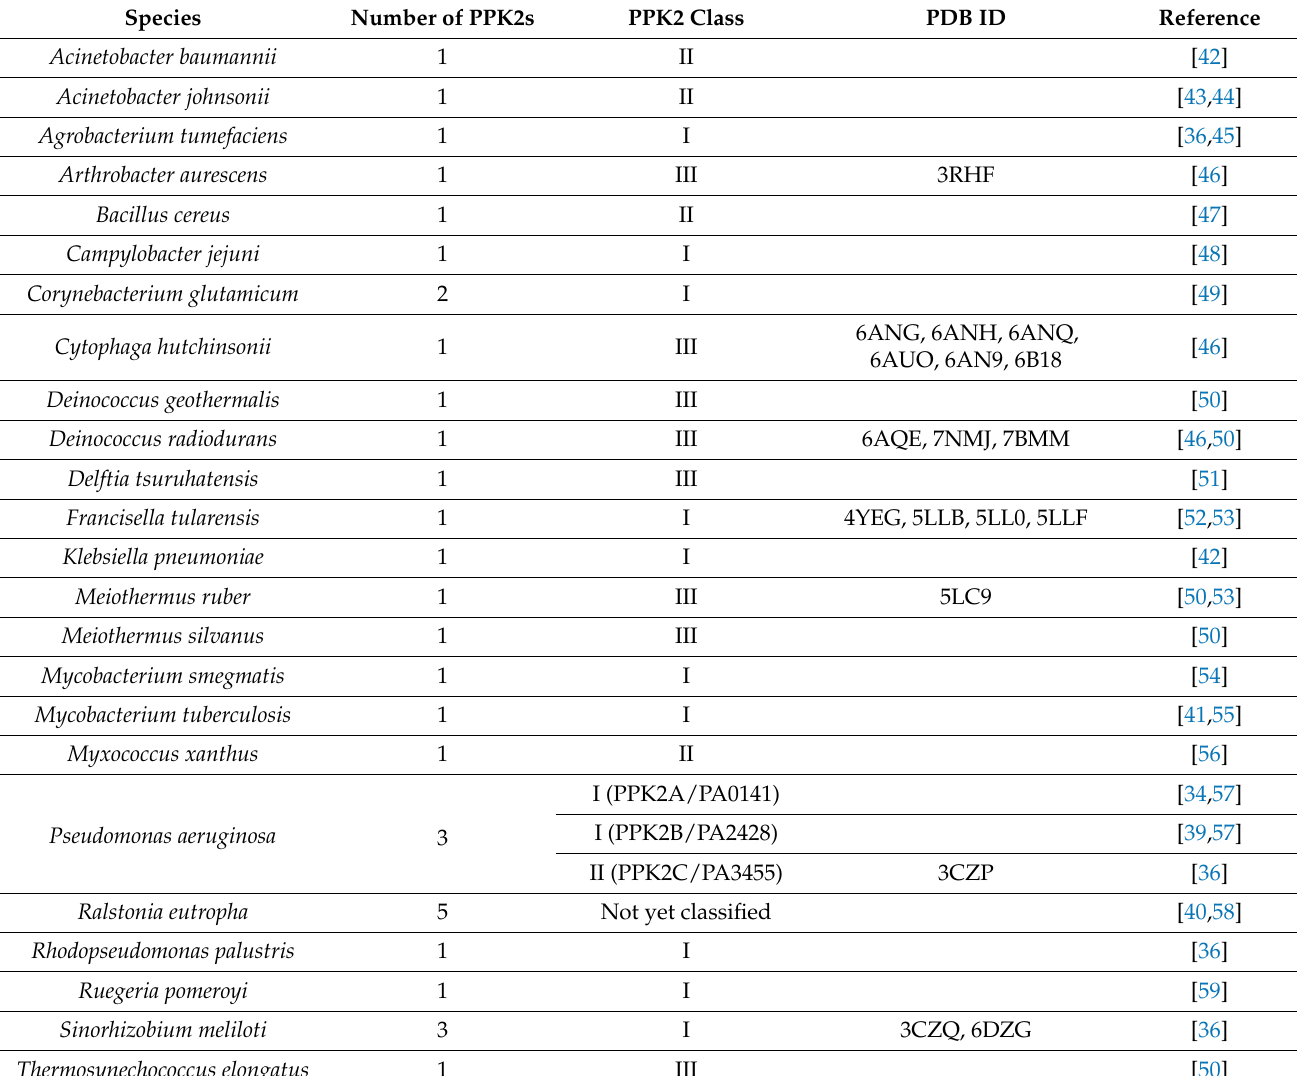
Table 1. Summary of bacterial species with characterized PPK2